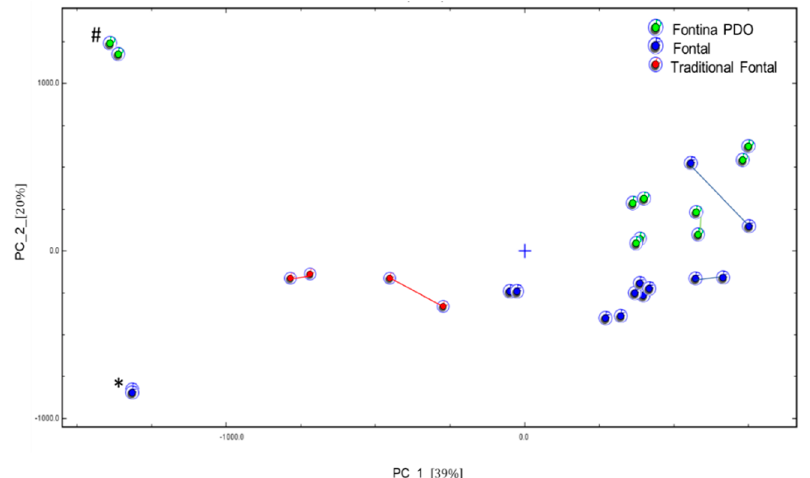
Figure 1. Plot of principal component (PC) analysis of commercial cheese samples. Duplicate samples are connected for clarity in identification. (#) Long ripened Fontina PDO cheese; (*) Fontal cheese produced in a mountain area.